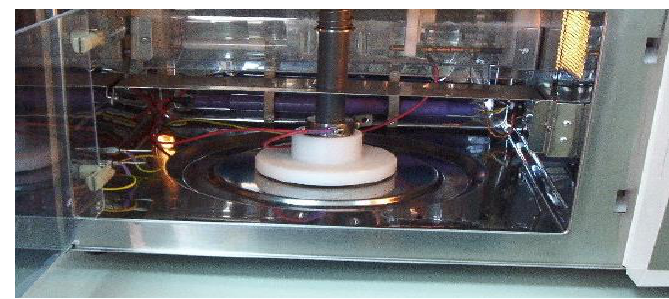
Figure 1. Working chamber of pulsed electric field (PEF) research stand.